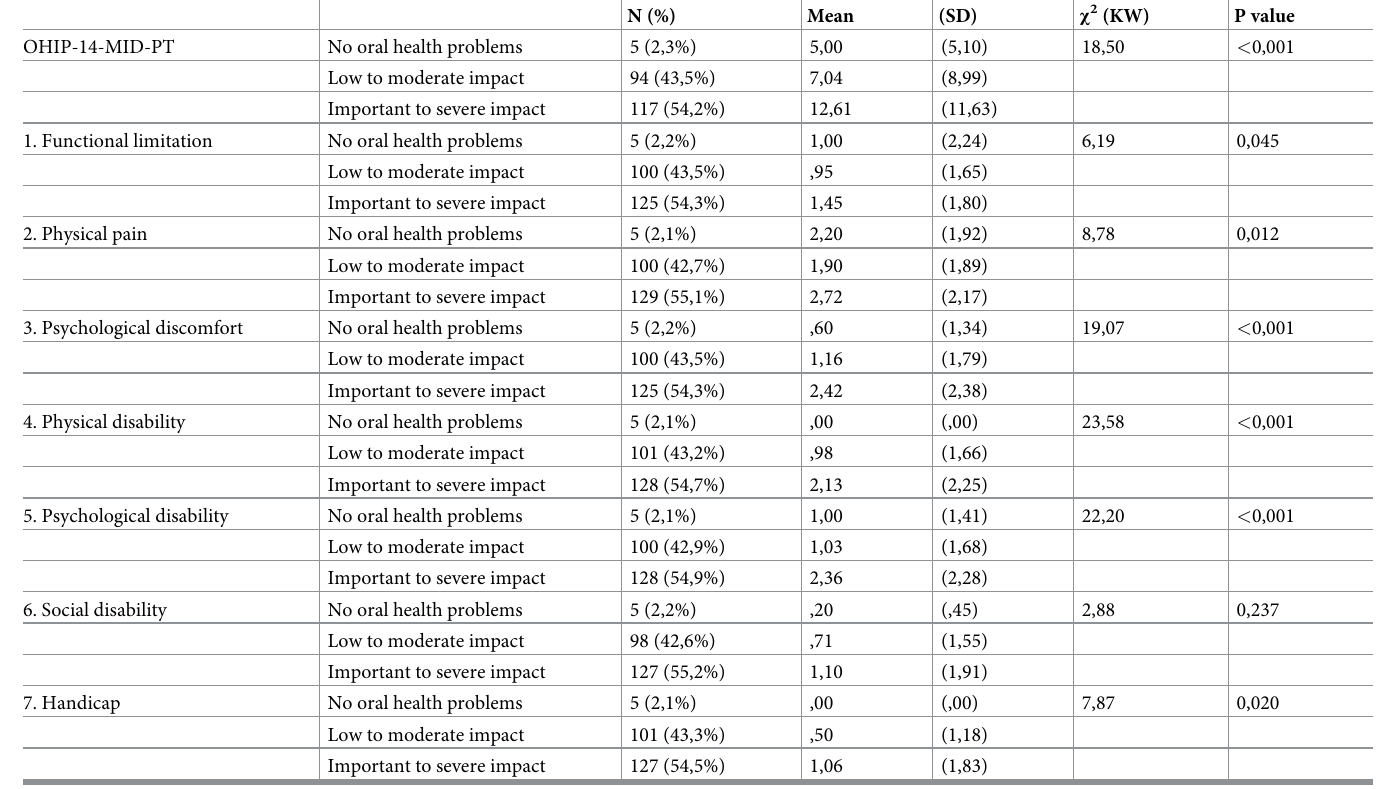
Table 3. Portuguese language validation of OHIP-14-MID-PT.